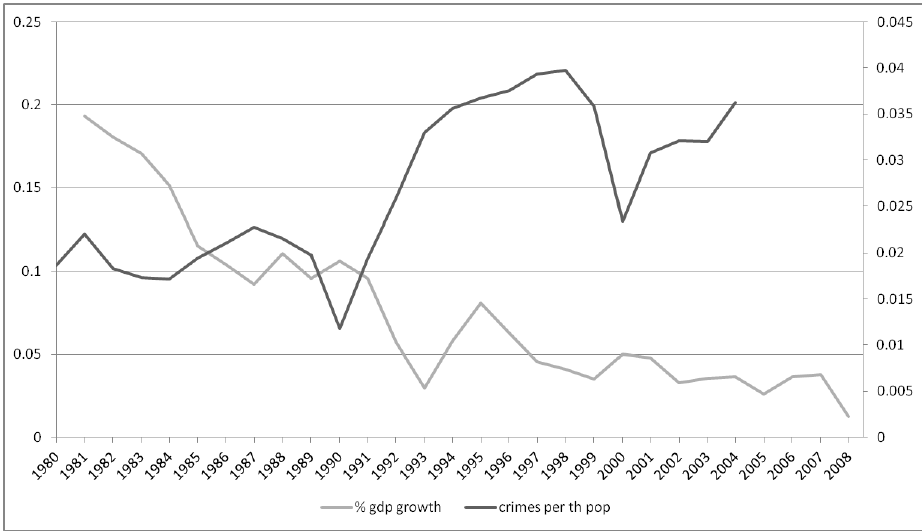
Yearly data are averaged over the full sample. GDP growth is measured as the percentage change from the past years' GDP growth; crimes are measured as per capita prosecutions for corruption crimes. Source: Italian Institute of Statistics